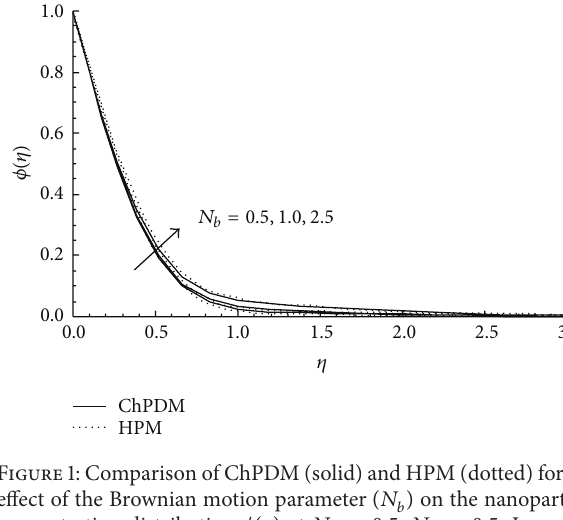
Figure 1: Comparison of ChPDM (solid) and HPM (dotted) for the effect of the Brownian motion parameter (𝑁 𝑏 ) on the nanoparticle concentration distribution 𝜙(𝜂) at 𝑁 𝑡 = 0.5 , 𝑁 𝑟 = 0.5 , Le = 10 , Ra 𝑥 / Pe 𝑥 = 0.5 , and 𝛼 = 𝜋/6 .